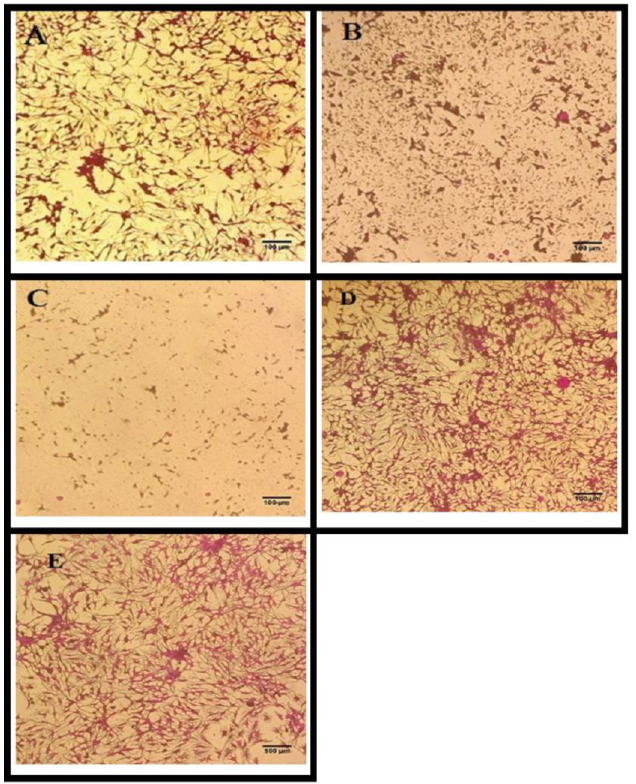
Fig 9. Cytotoxicity of synthesized AgNPs against cancerous HepG2 cell lines upon treatment for 24 hrs. Magnification = 200X, Scale = 100 μ m. A = R-AgNPs, B = S-AgNPs, C = RS-AgNPs, D = untreated cells, E = DMSO 1% (negative